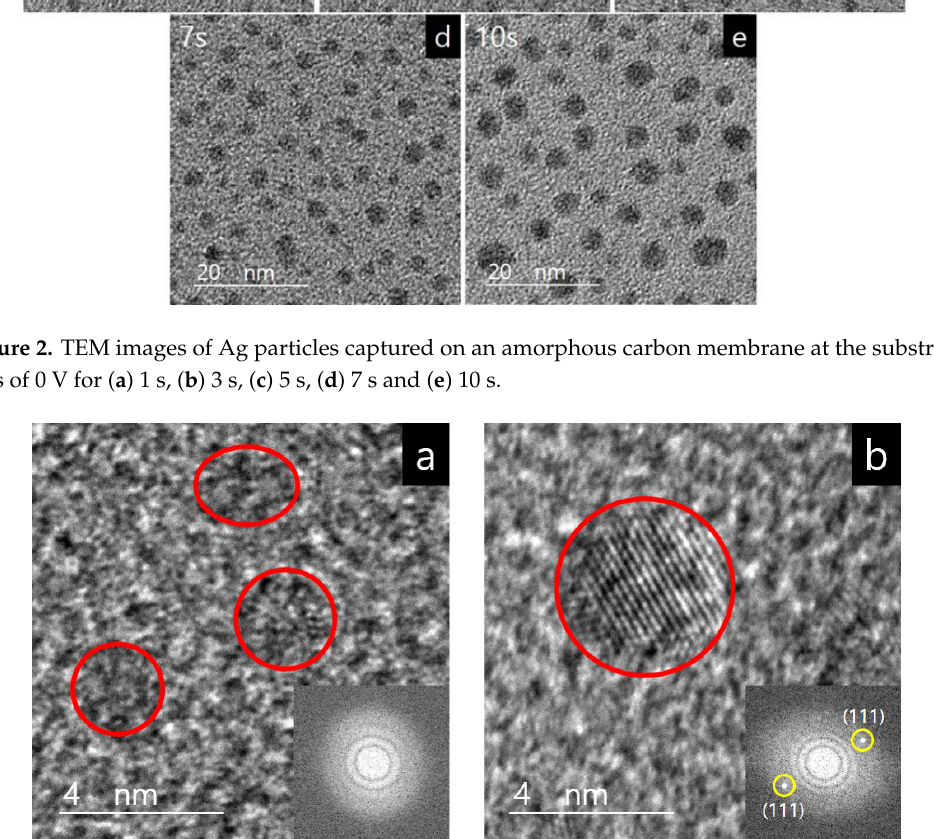
Figure 3. HRTEM image and FFT information (inset of the lower right in the image) of Ag sputtered particles captured on an amorphous carbon membrane at the substrate bias of 0 V for ( a ) 1 s and ( b ) 10 s.